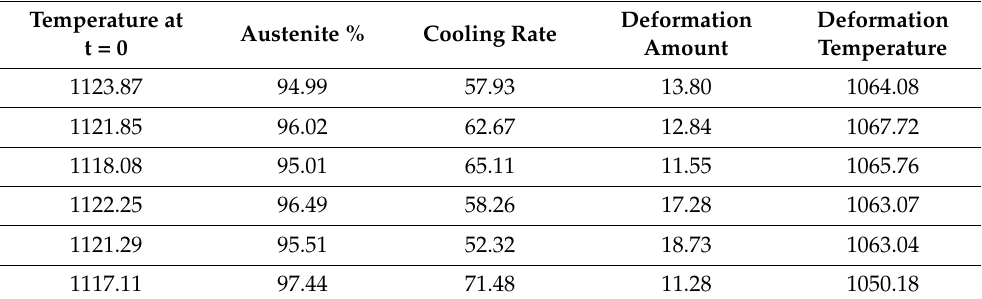
Figure 12. Feasible Region of the Processing Parameters (Forming and Quenching).